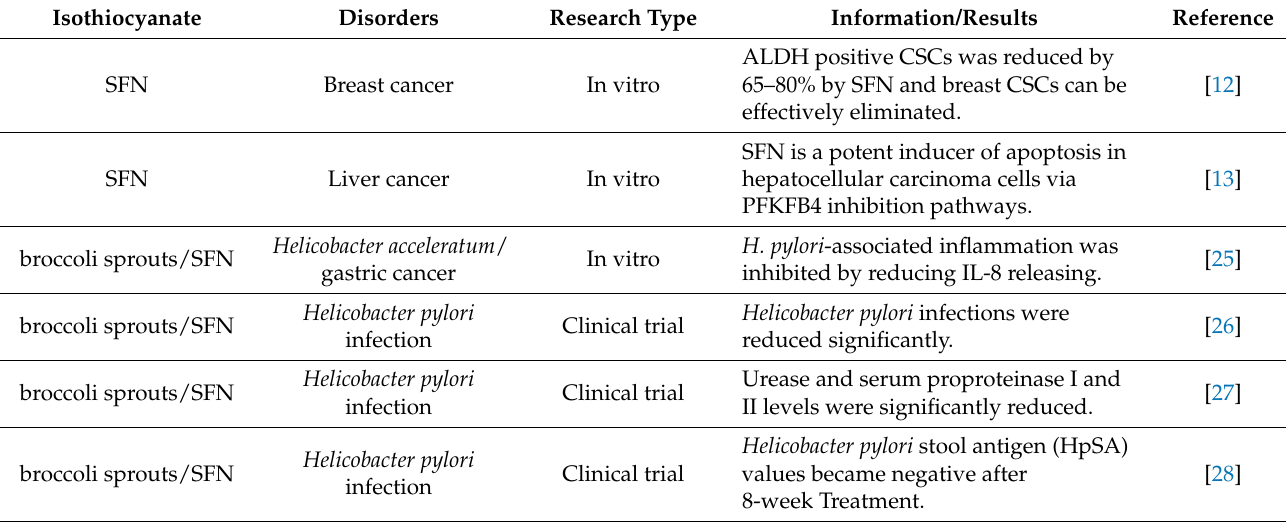
Table 1. Summary of main research on antitumor effect of